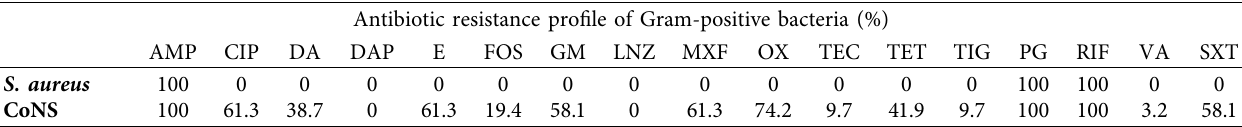
Figure 2: Monomicrobial (a), bimicrobial (b), and trimicrobial (c) contamination of the medical devices studied. Table 3: Antibiotic resistance profile of Gram-positive